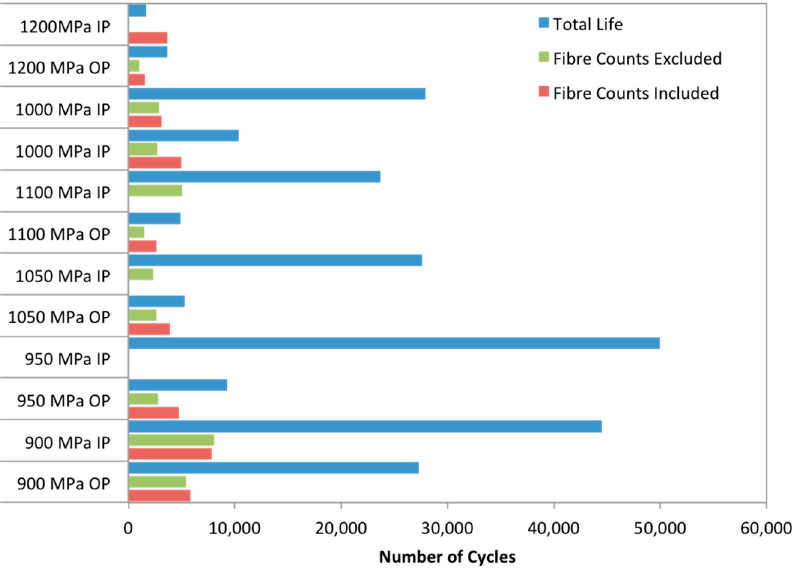
Figure 13. Striation counts as a proportion of total life of tested specimens.